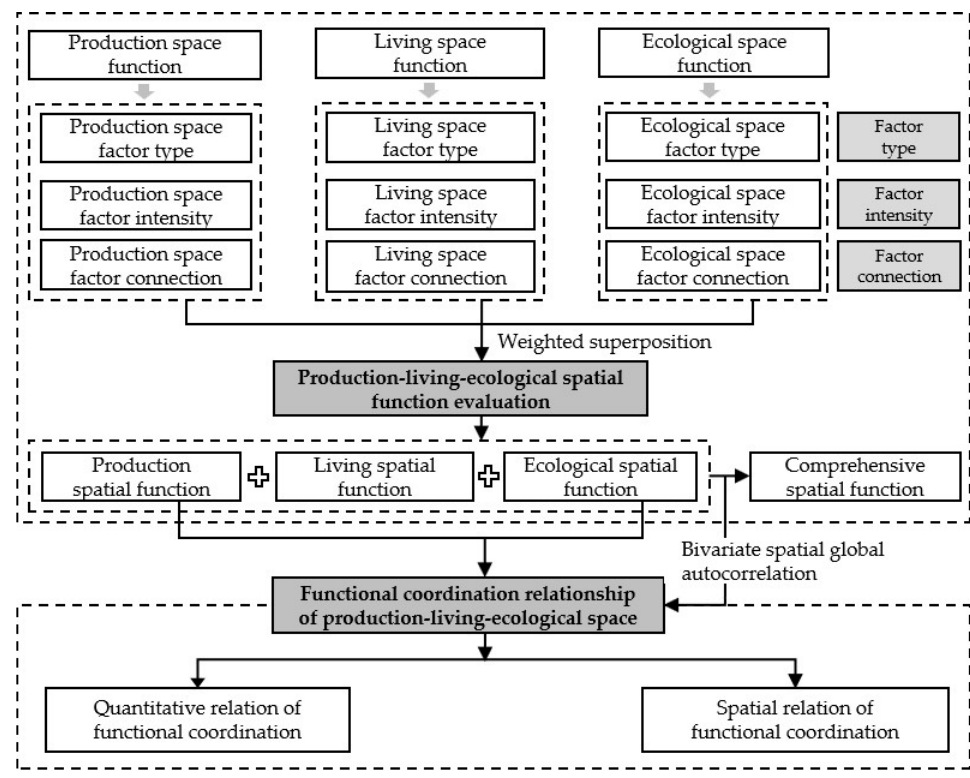
Figure 2. The research technical framework.